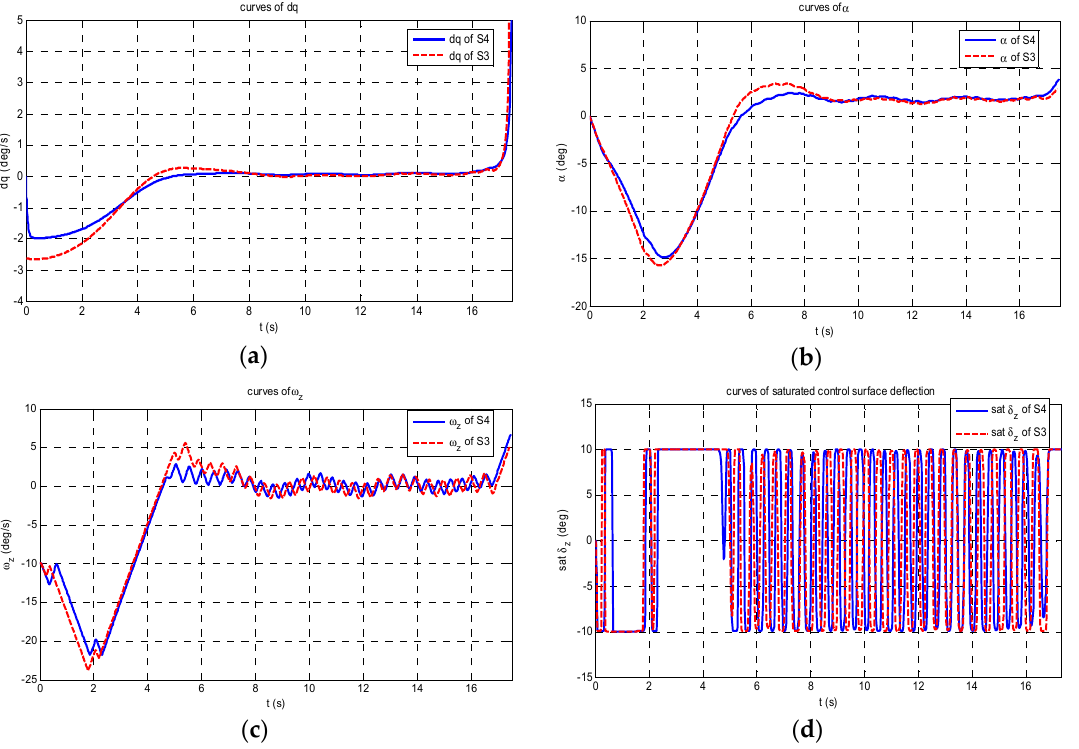
α . ω q , ( b ) curves of α , ( c ) curves of ω z , and ( d ) , ( c ) curves of z , and